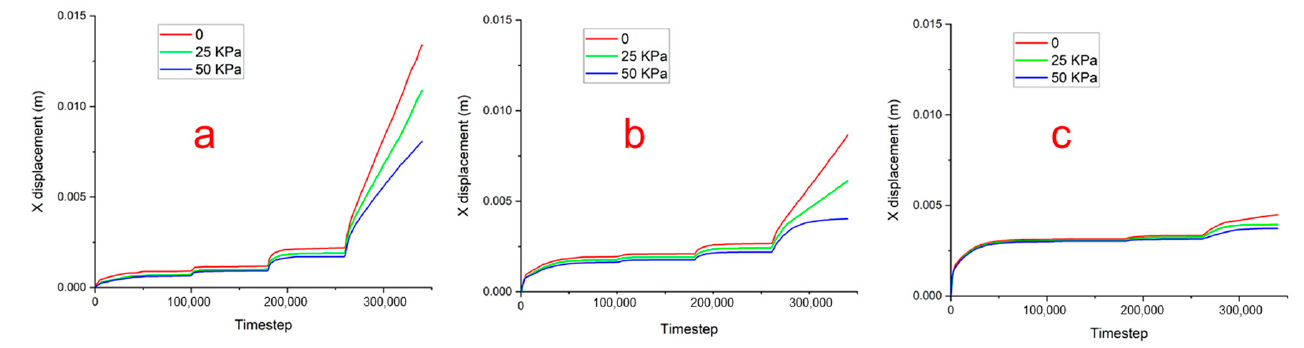
Figure 18. Sensitivity analysis of S0 cohesion by varying from 0 to 50 KPa, showing the displacement of history points in X direction ( a ) H1, ( b ) H2, and ( c ) H3.